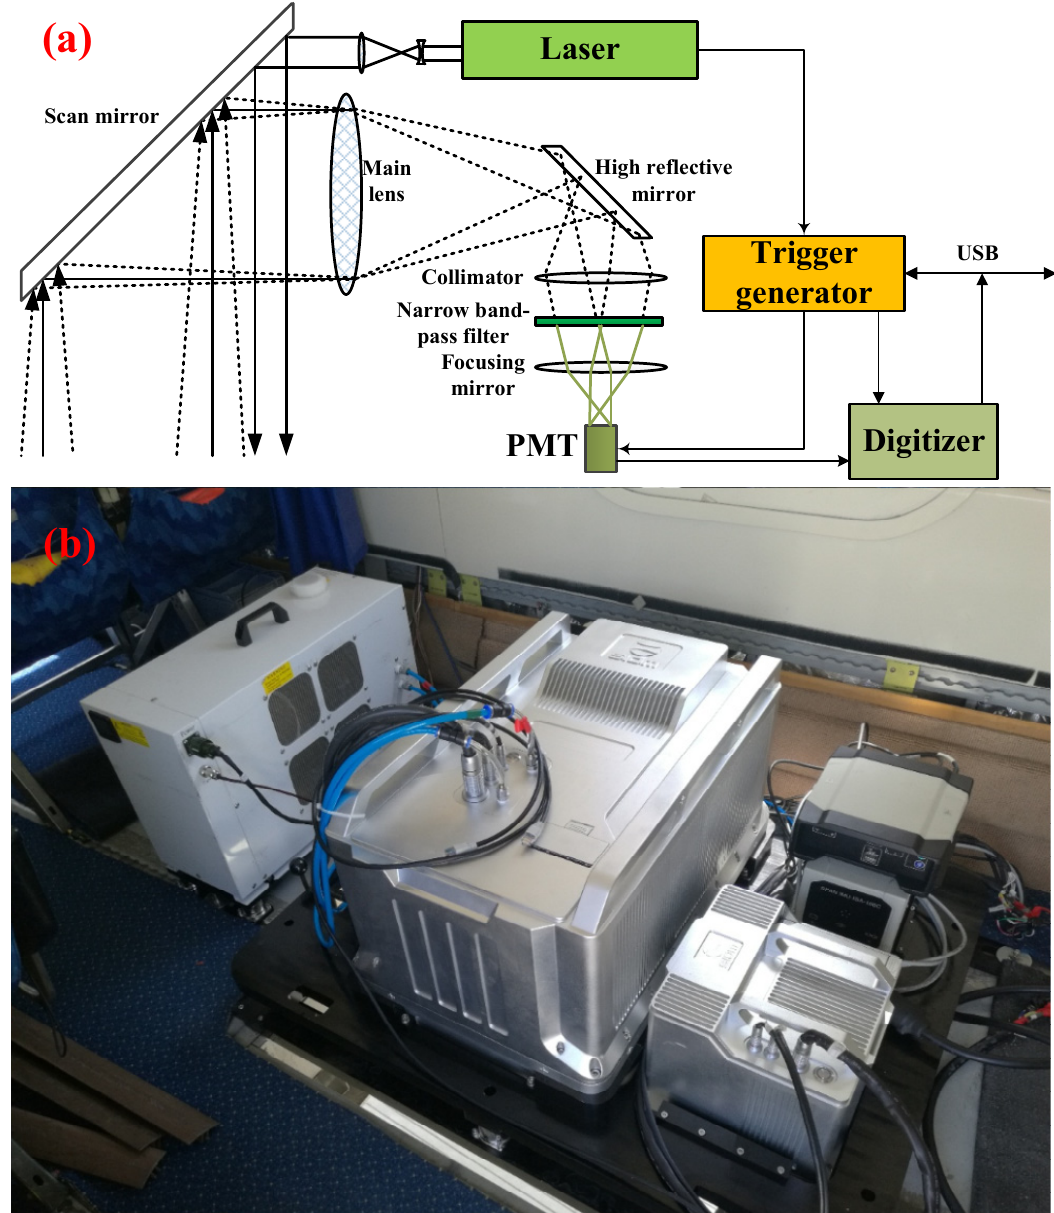
Figure 1. Diagram of the major optoelectronic components ( a ), and a picture of the LiDAR ( b ).